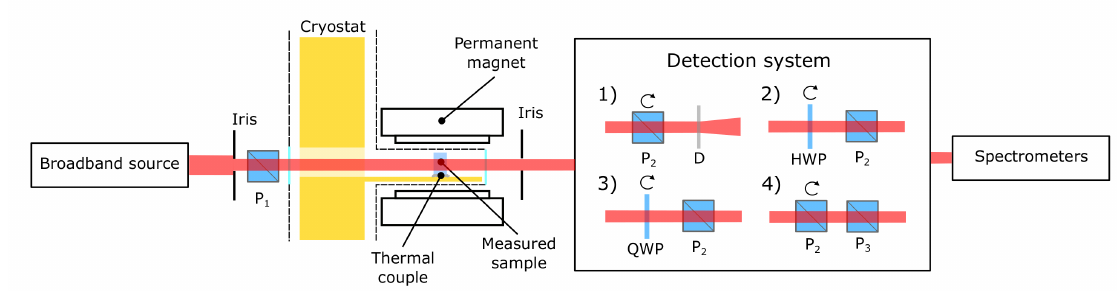
Figure 2. Experimental setup for the Verdet constant characterization.